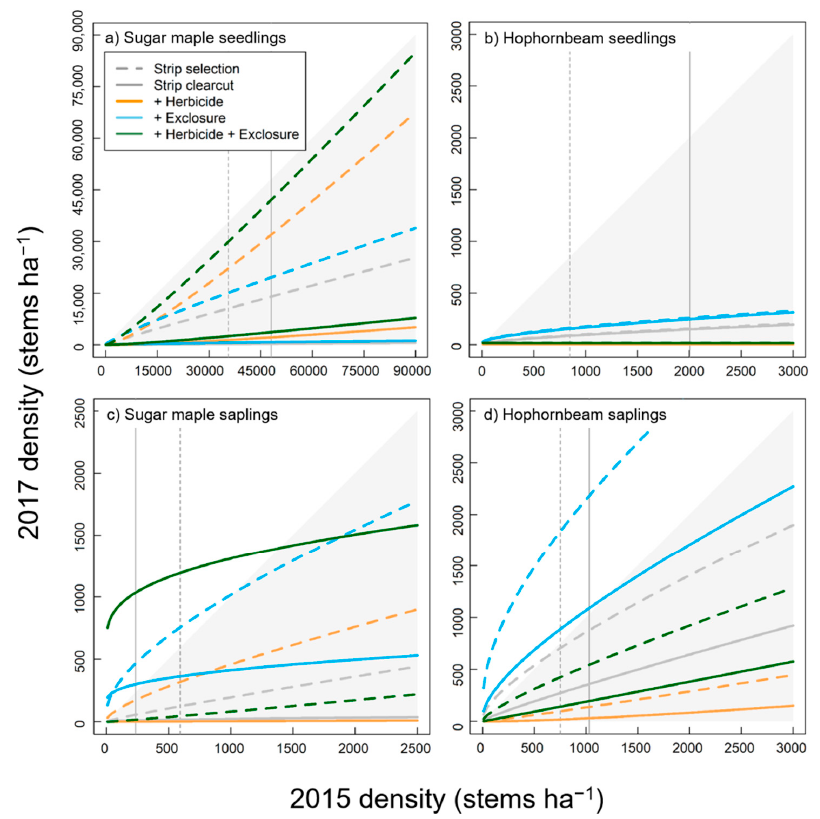
(Herb), and exclosure (Excl) treatments in a managed northern hardwood forest in the Upper Pen- insula of Michigan, USA. Note the different y -axis ranges.